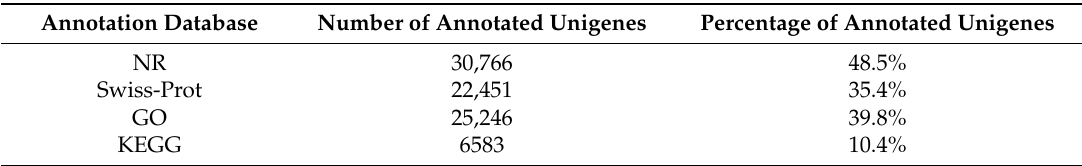
Table 3. Summary of unigene annotation in Pinus tabulaeformis